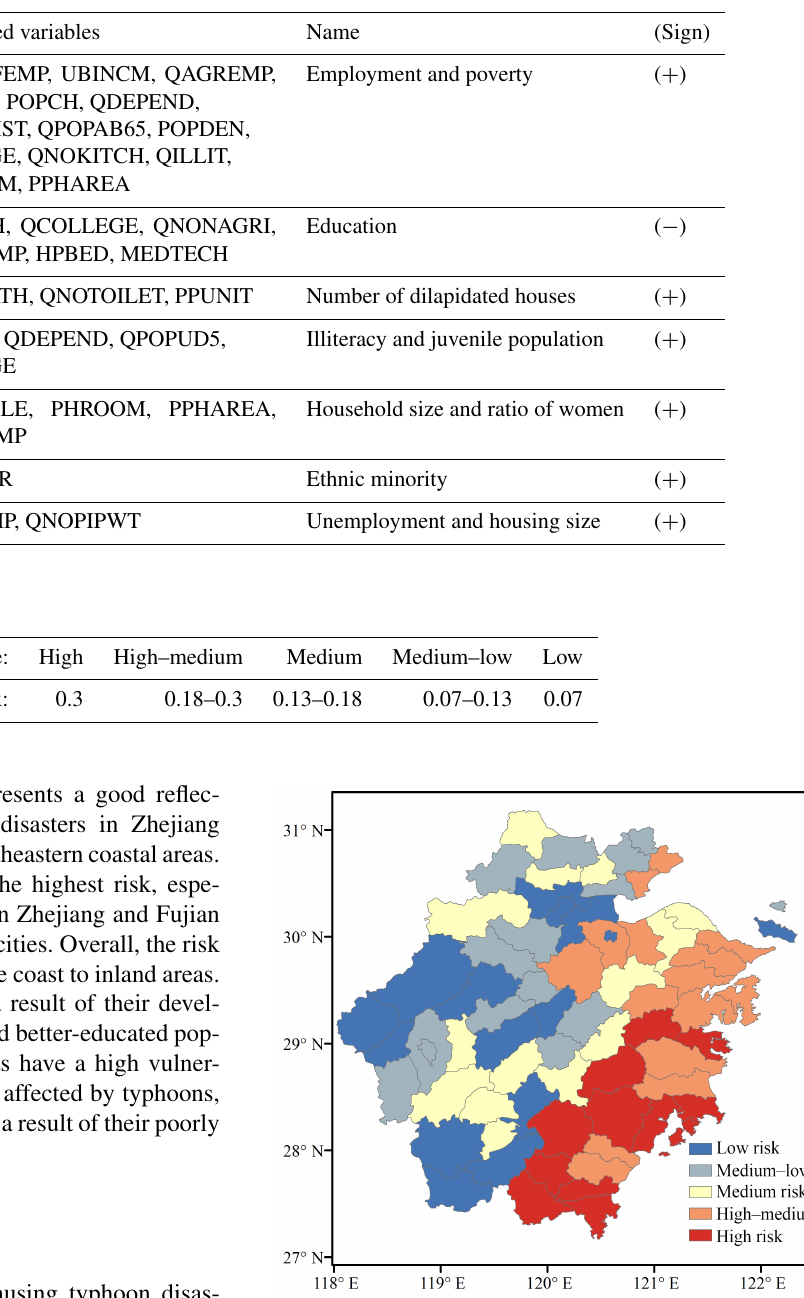
Figure 11. Risk zoning of typhoon disasters in Zhejiang